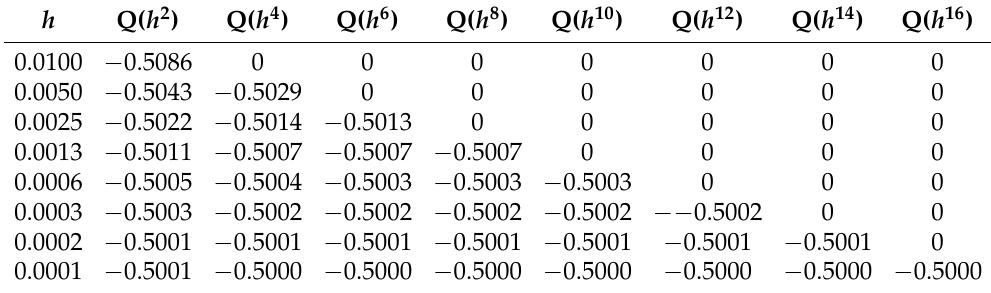
Table 8. The numerical result for α = 1 using our central formula with Richardson